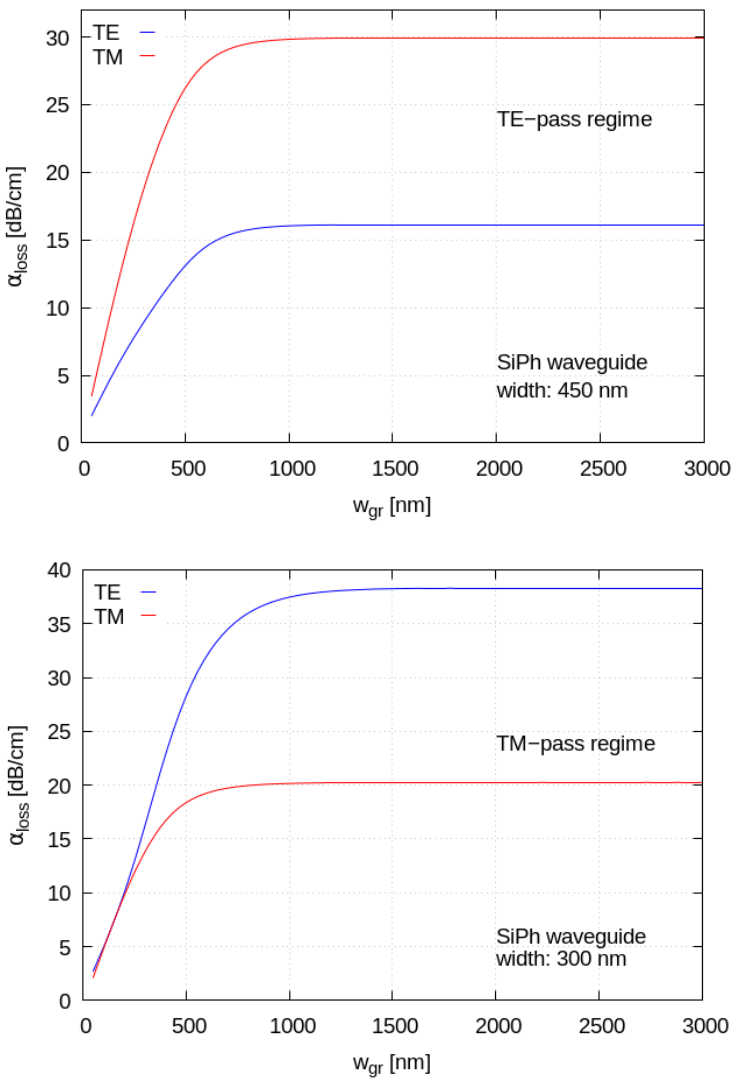
Figure 8. ( Top ): Mode absorption coefficients for a waveguide of width 450 nm. ( Bottom ): Mode absorption coefficients for a waveguide of width 300 nm. The absorption has been calculated as a function of the graphene width.